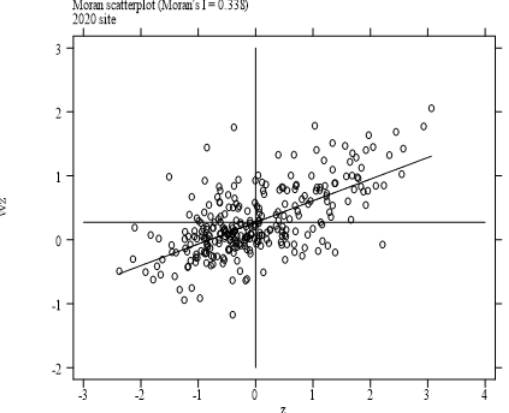
Figure 1. Moran’s scatter plot of enterprises’ site selection.